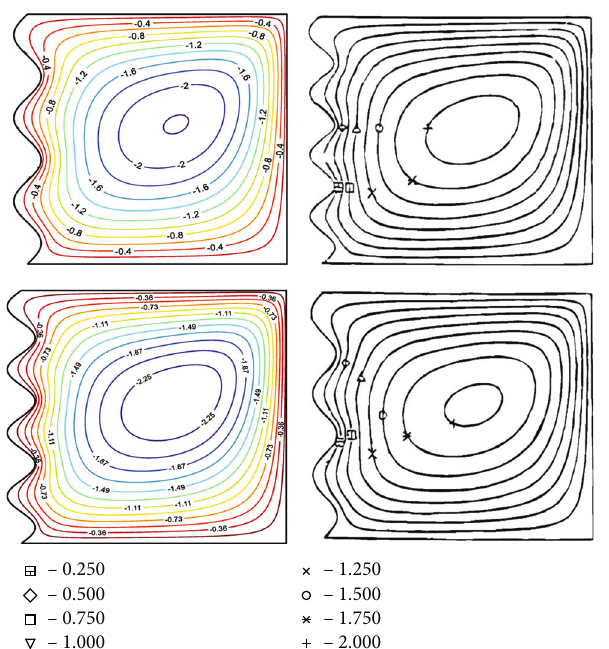
Figure 2: Validation of current streamlines with published [8] results for the sinusoidal undulated surface at Da = 10 − 5 , ϕ = 0 : 0 , Ra = 5 × 10 6 , A = 0 : 05 , and N = 4, 3